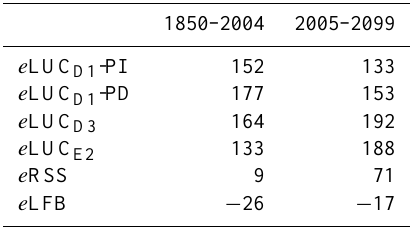
Table 3. Cumulative emissions (GtC) over historical and future pe- riod for different methods ( e LUC D1 , e LUC D3 , e LUC E2 ) and com- ponent fluxes ( e RSS, e LFB). e LUC D1 -PI and e LUC D1 -PD refer are quantified under preindustrial (PI) and present-day (PD) environ- mental conditions.